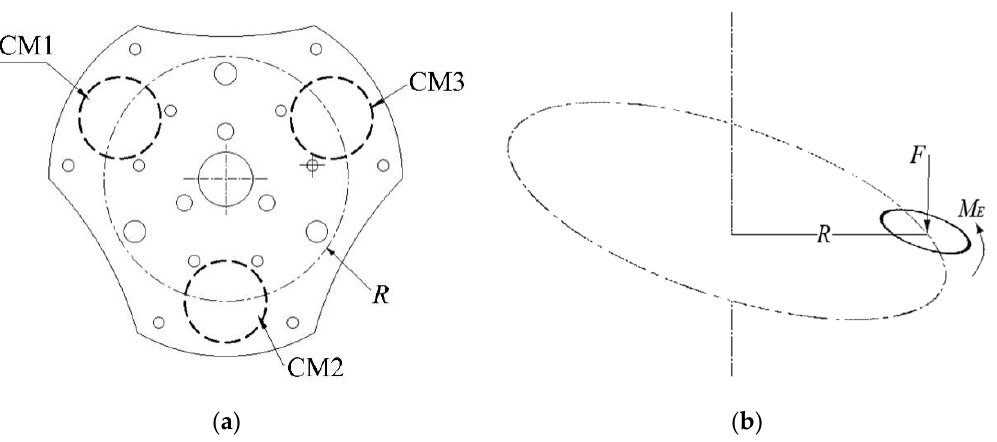
Figure 5. Force-distribution diagram of the flexible connecting plate: ( a ) the configuration of the three groups of motion chamber structures in the connecting plate; ( b ) schematic diagram of the index circle radius, load, and driving moment of the connecting plate and connecting groove.